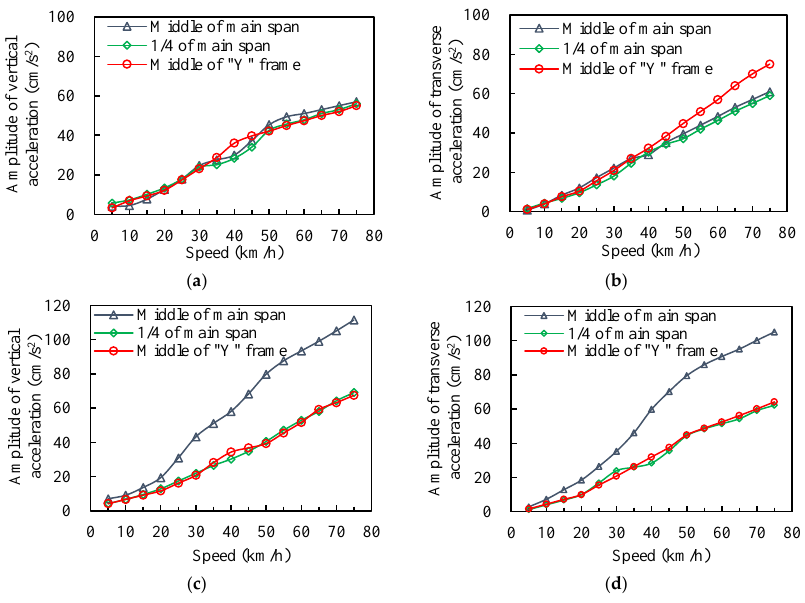
Figure 11. The amplitude of the accelerations of the bridge: ( a ) and ( b ) single line; ( c ) and ( d ) double line.